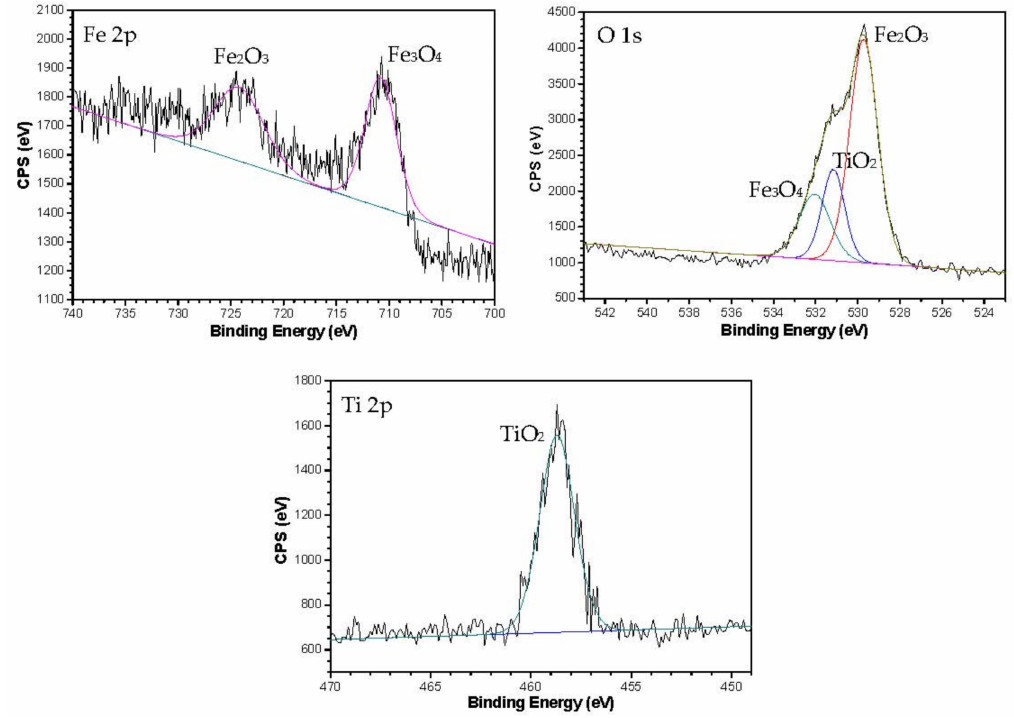
Figure 8. XPS spectra of Fe 2p, O 1s and Ti 2p on the oxide scales surface lubricated with nano-TiO 2